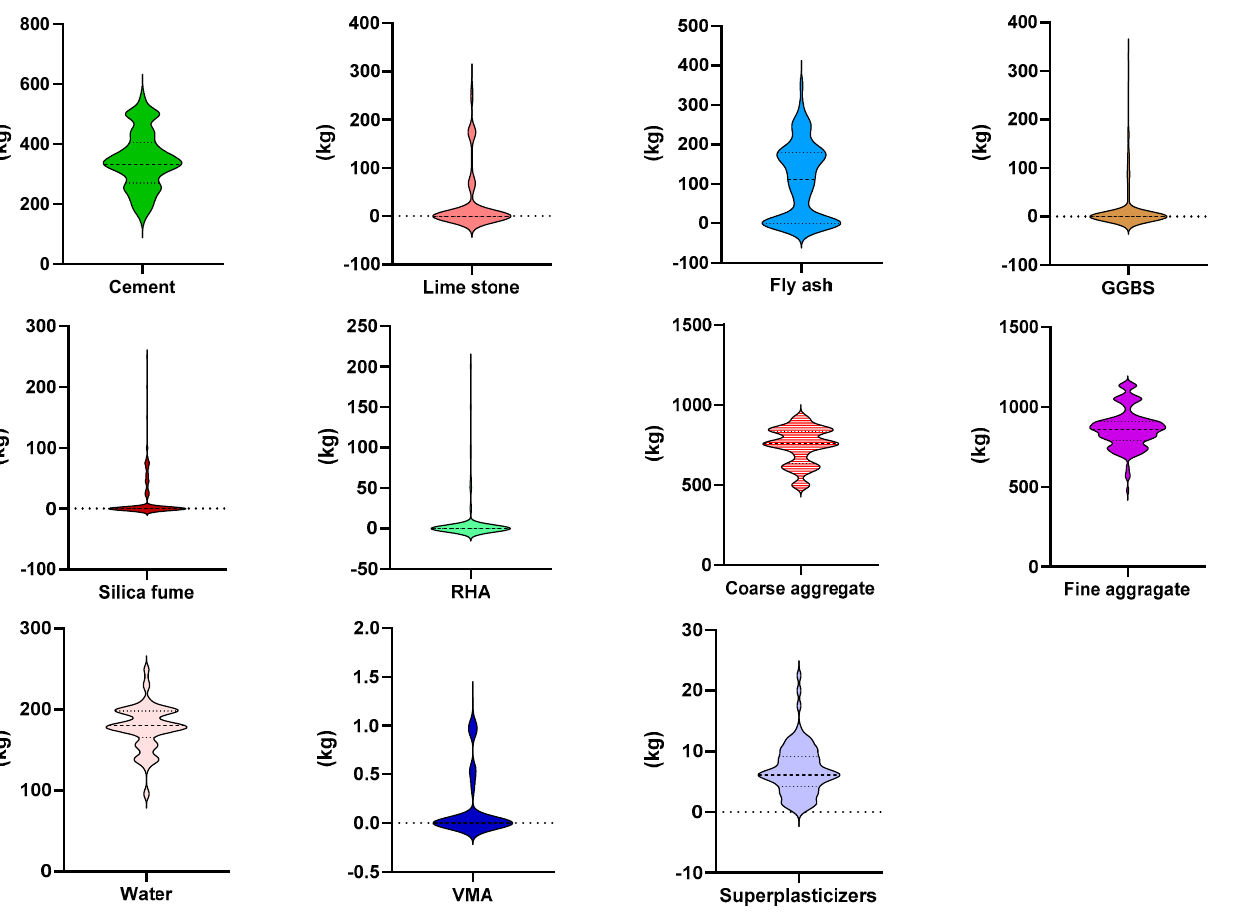
Figure 2. Violin plots distribution of the input parameters.